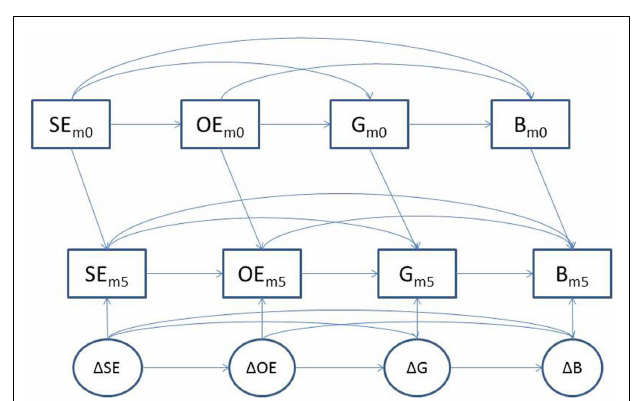
FIGURE 1 | Panel analysis model showing parallel relationships between social cognitive constructs and nutrition behavior at baseline and month 5 and residualized change (disturbance terms) for each variable. Note: SE, self-efficacy; OE, outcome expectations, G, goals, B, behavior (either FVC or